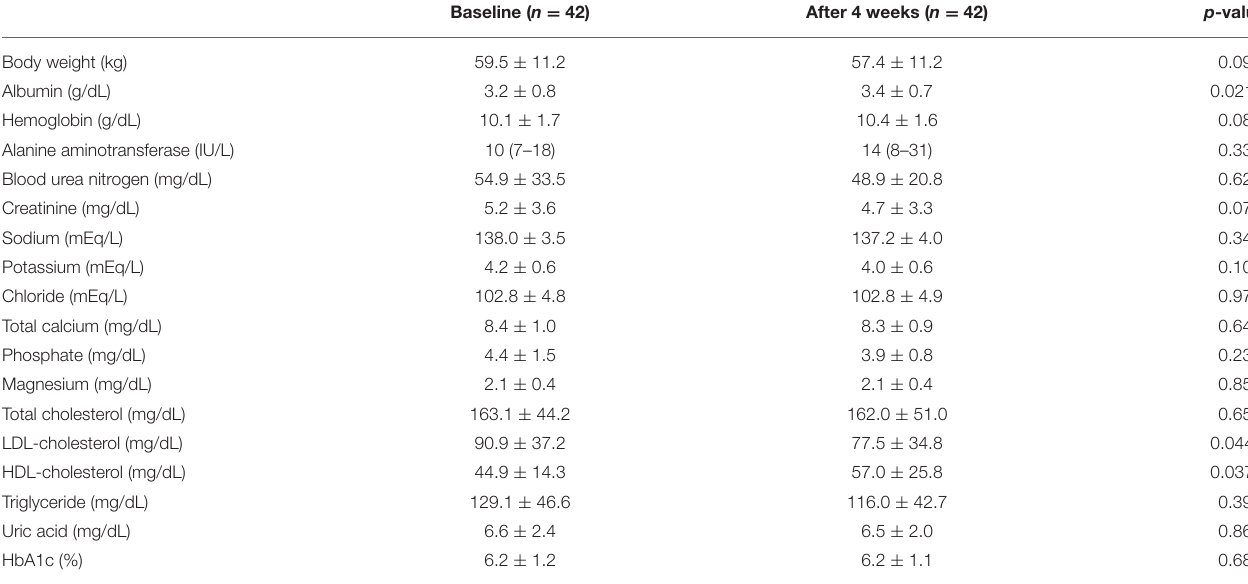
TABLE 3 | Clinical parameters before and after 4 weeks of elobixibat